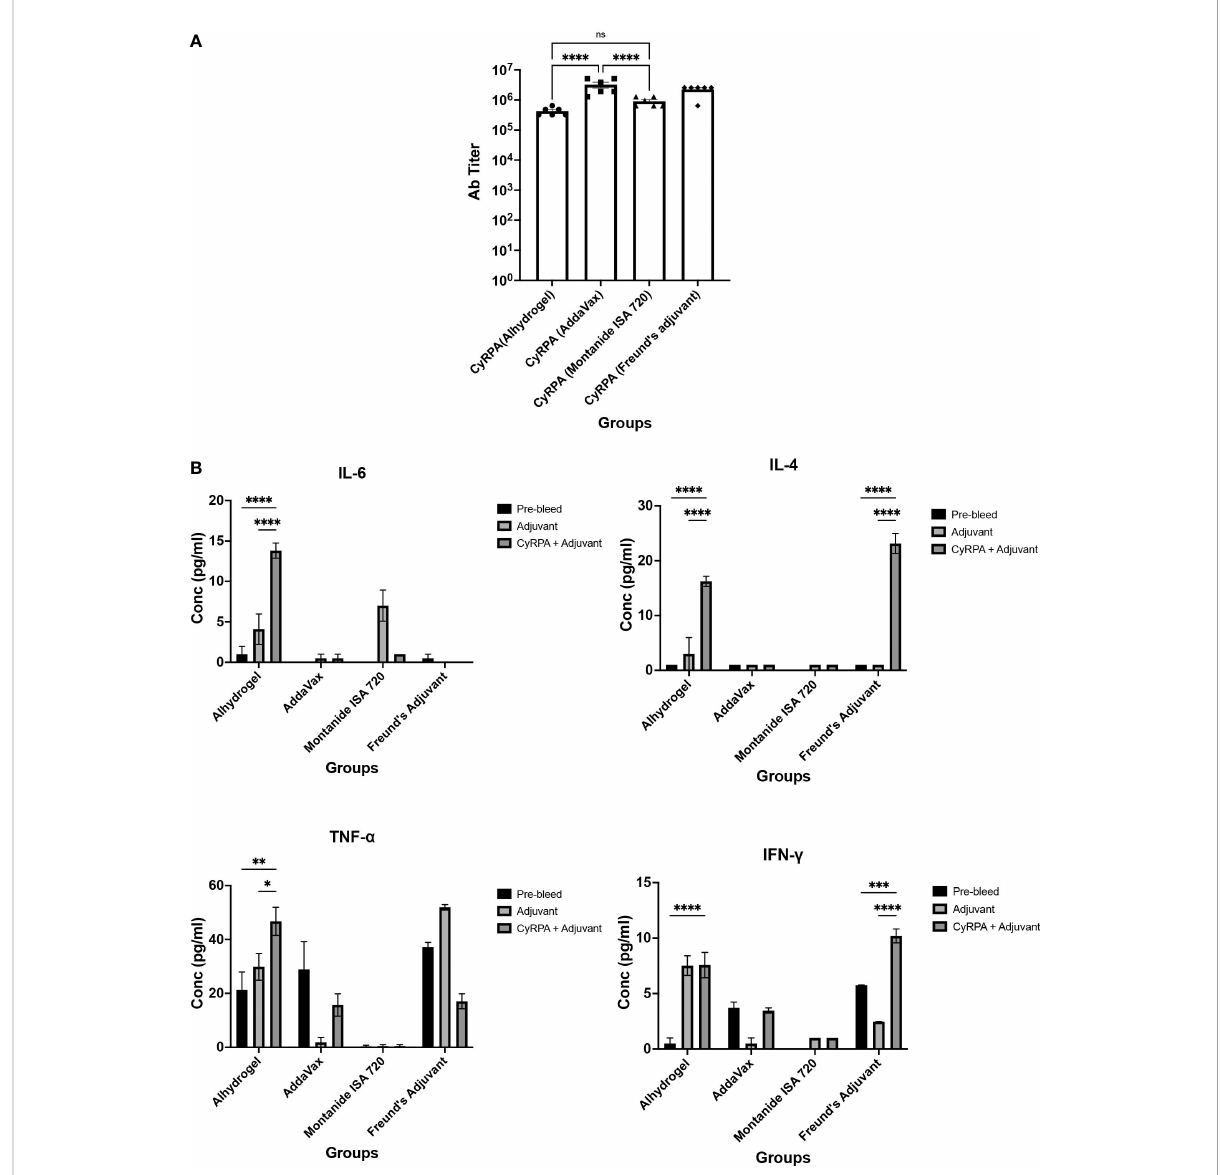
FIGURE 6 Humoral and Cellular Immune Responses against Tag-free CyRPA Vaccine Formulated with Commonly used Adjuvants. (A) BALB/c mice (n = 6 per group) were immunized intramuscularly with tag-free CyRPA formulated with three adjuvants- Alhydrogel, AddaVax and Montanide ISA 720 and Freund ’ s adjuvant (CFA/IFA) as a control. Enzyme-Linked Immunosorbent Assay (ELISA) was performed to calculate antibody titers in Day 70 sera. CyRPA (AddaVax) and CyRPA (Freund ’ s Adjuvant) induced high antibody titers (~32,00,000 and ~25,60,000 respectively) followed by CyRPA (Montanide ISA 720) (~6,40,000) and CyRPA (Alhydrogel) (~4,20,000). ELISA cut-offs were calculated as the mean OD 490 of pre-bleed sera plus three times standard deviation. The bars and error bars show mean and standard error values of each vaccine group respectively. Individual mice titers are also shown. The P values were calculated by two-way ANOVA with Bonferroni post-hoc testing. (B) Levels of T H 1 and T H 2 responses were measured in BALB/c mice serum immunized with CyRPA+adjuvant or adjuvant alone by cytometric bead arrays (CBA) for mouse serum cytokines using fl ow-cytometry. CyRPA/Alhydrogel vaccine induced IL-4, IL-6, TNF- a when compared to the Alhydrogel only group while no detectable responses were observed for CyRPA/AddaVax and CyRPA/Montanide ISA 720 groups. However the control group- CyRPA/Freund ’ s Adjuvant observed increased levels of IFN- g and IL-4. The pre-bleed, adjuvant and CyRPA+adjuvant plots refer to the cytokines detected in sera from groups of 6 mice before immunization, post-immunization of adjuvant and post-immunization of CyRPA formulation respectively. The bars and error bars show mean and standard error values of each group respectively. The P values were calculated by two- way ANOVA with Bonferroni post-hoc testing. * P ≤ 0.05 ** P ≤ 0.01, *** P ≤ 0.001, **** P ≤